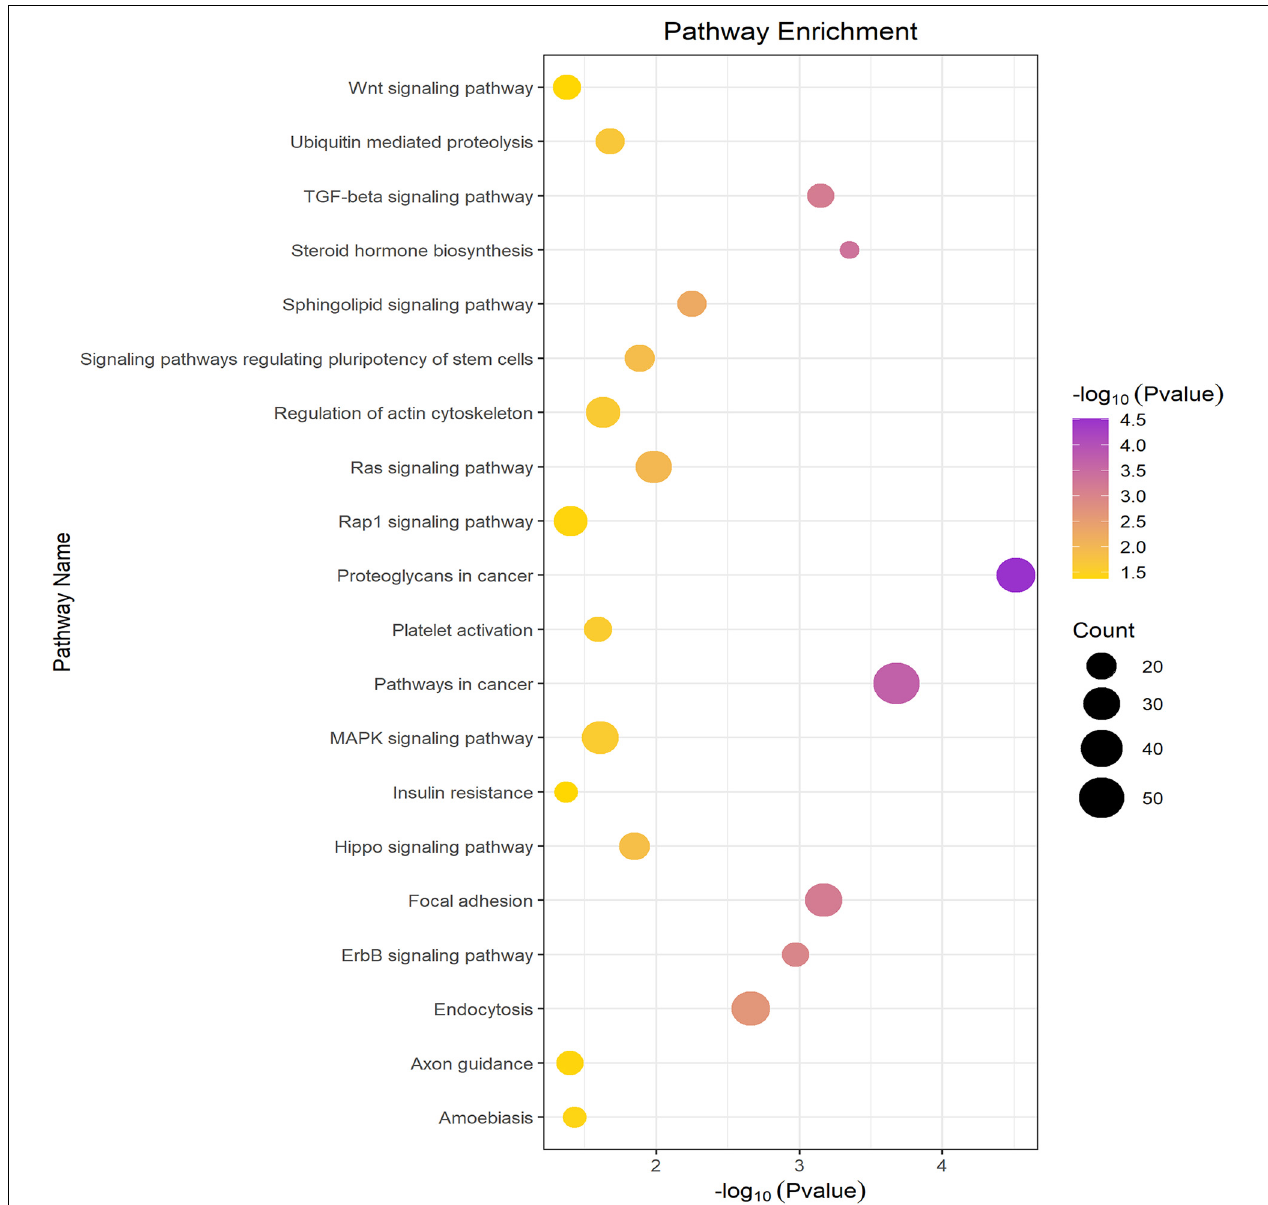
FIGURE 6 | KEGG pathway analysis of the downstream target